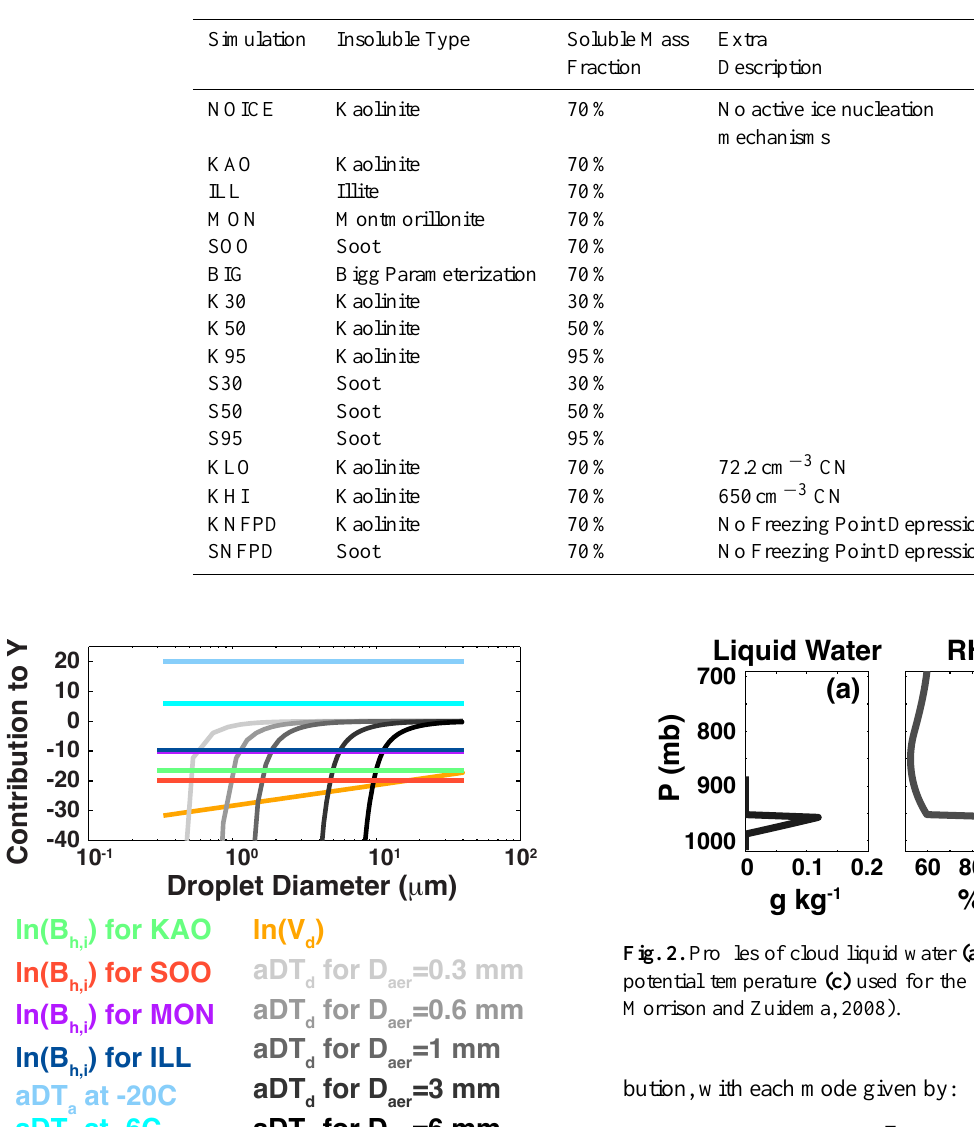
Table 2. An overview of simulations completed in this study.